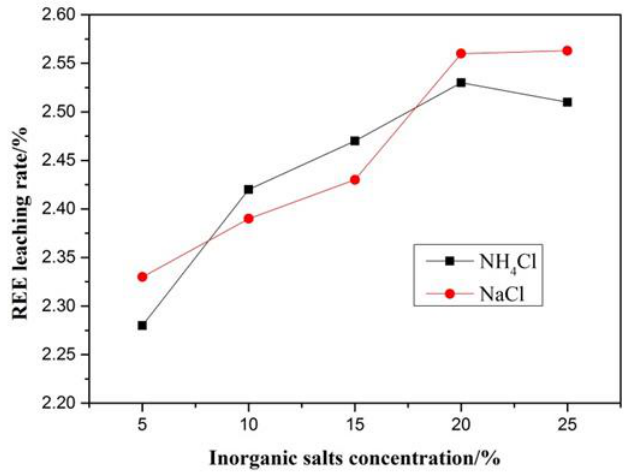
Figure 6. Results of inorganic salts leaching test.